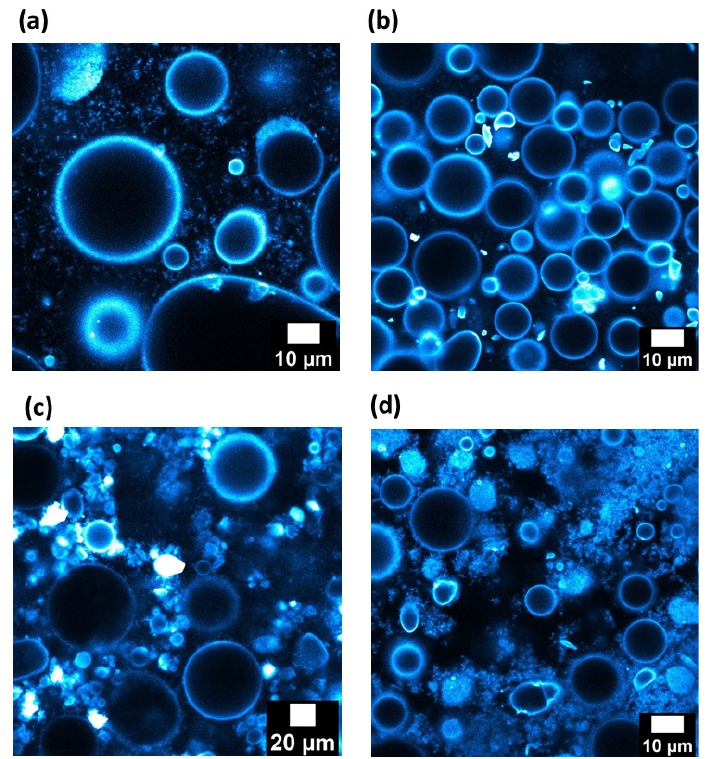
Figure 7. Confocal fluorescence images of ( a , c ) Paraffin/W and ( b , d ) Dodecane/W direct emulsions prepared with ( a , b ) 1 wt.% and ( c , d ) 4 wt.% of partially hydrophobic silica particles.